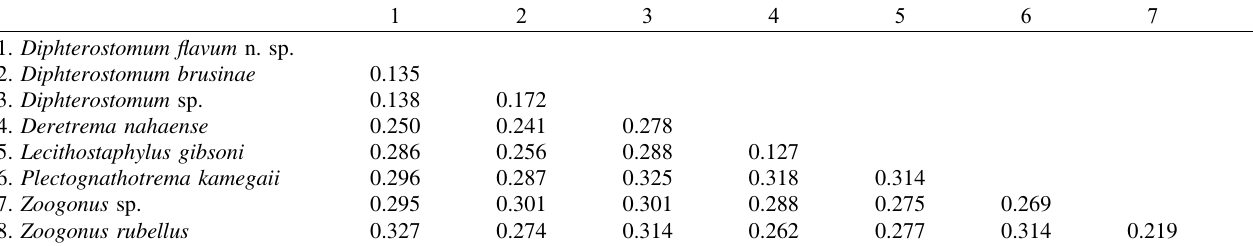
Table 2. Pairwise nucleotide sequence comparisons between zoogonid species calculated as the percentage of nucleotide differences (gaps treated as missing data) for the aligned ITS2 sequences ( n = 403